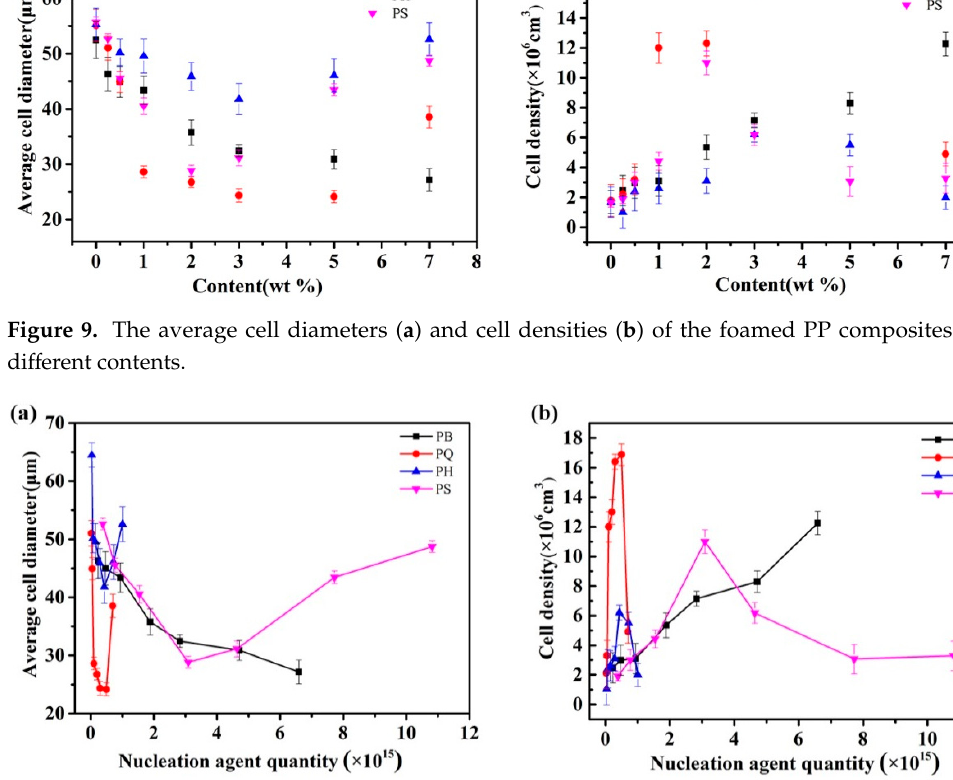
Figure 10. Average cell diameters ( a ) and cell densities ( b ) of the foamed PP composites with different nucleation agent quantities.